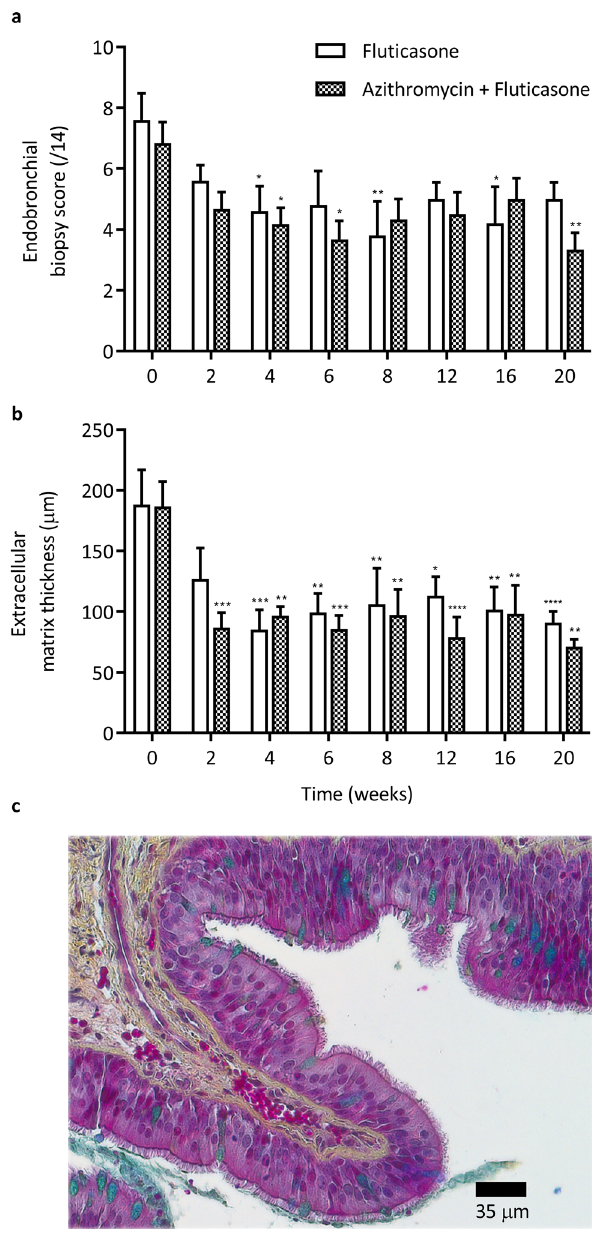
Figure 4. Endobronchial biopsies. Histological score ( a ) and extracellular matrix thickness ( b ) of the endobronchial biopsies (mean and standard error of the mean). There was a significant time main effect but no group difference with the two-way ANOVA for the score (p = 0.001) and the extracellular matrix thickness (p < 0.0001). *p < 0.05, **p < 0.01, ***p < 0.001, ****p < 0.0001 compared to baseline values with Dunnett’s multiple comparison tests. c) Epithelium from a central airway stained with